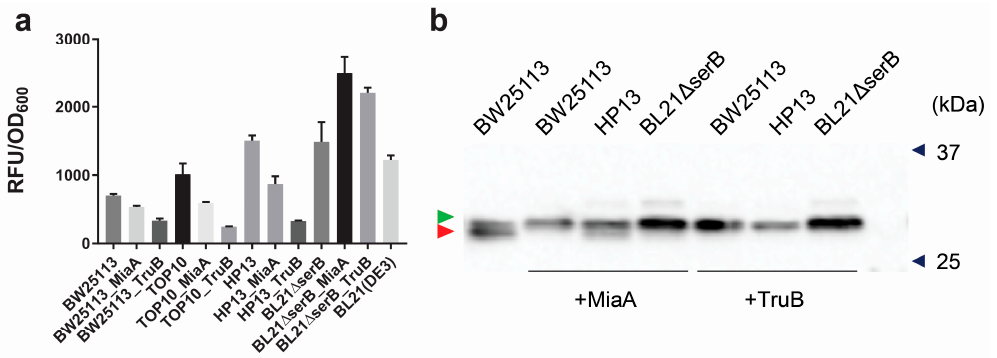
Figure 5. Overexpression of MiaA and TruB does not improve total yields of sfGFP-2TAG, but improves specific Sep incorporation markedly. ( a ) Stop codon read-through facilitated by Sep-OTS in the presence of overexpressed MiaA and TruB. Assay was executed in the strains BW25113 and TOP10, as well as the serB deletion strains BL21 Δ serB and HP13. The values represent the mean ± S.D. derived from 4–8 biological replicates. ( b ) Phos-tag TM mobility shift analysis of GFP-2TAG isolated from the corresponding strains (marked above the membrane). Overexpression of MiaA and TruB is indicated. Deleted genes are denoted above the wells, except for the parental BW25113 strain. Proteins were detected by Western blot using anti-GFP antibodies. The green arrow shows the position of the Sep-containing fraction, while the red one points to the position of nonphosphorylated, wild-type GFP. Control fraction containing GFP isolated from the BW25113 strain is also shown.